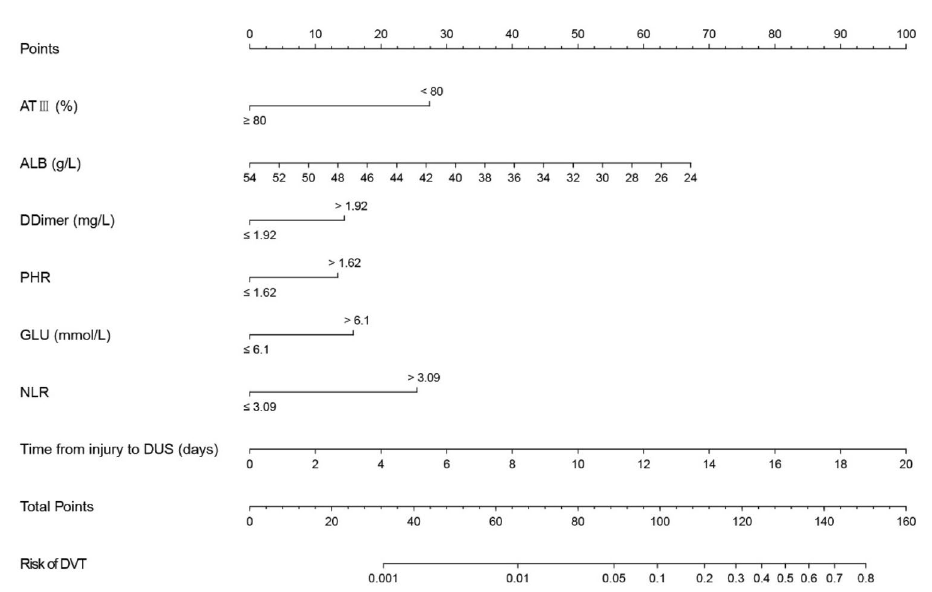
Figure 2. Nomogram for predicting preoperative DVTs in patients with isolated calcaneal fracture. The sum of the scores of each predictor (D-dimer, albumin, blood glucose, time from injury to DUS, NLR, PHR, and AT III) corresponds to the risk of